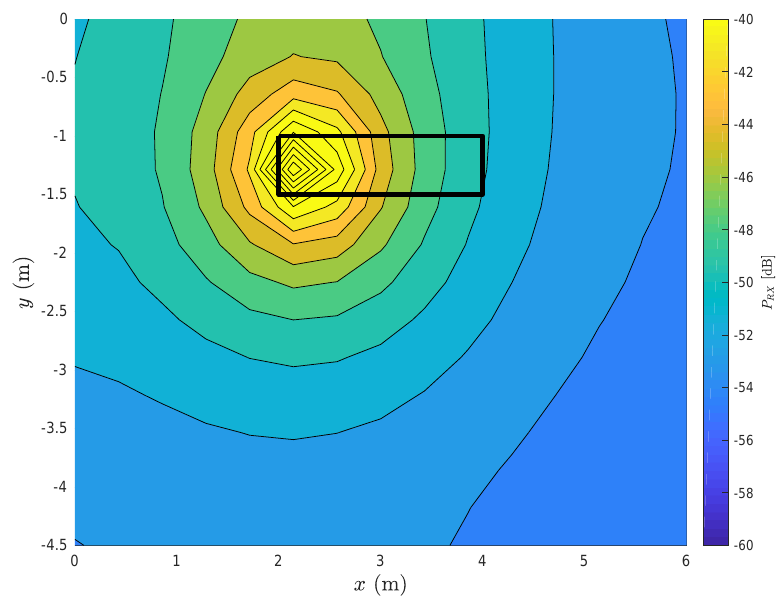
Figure 5. Contour of received power along the room considering a SISO system (i.e., M = N = 1).